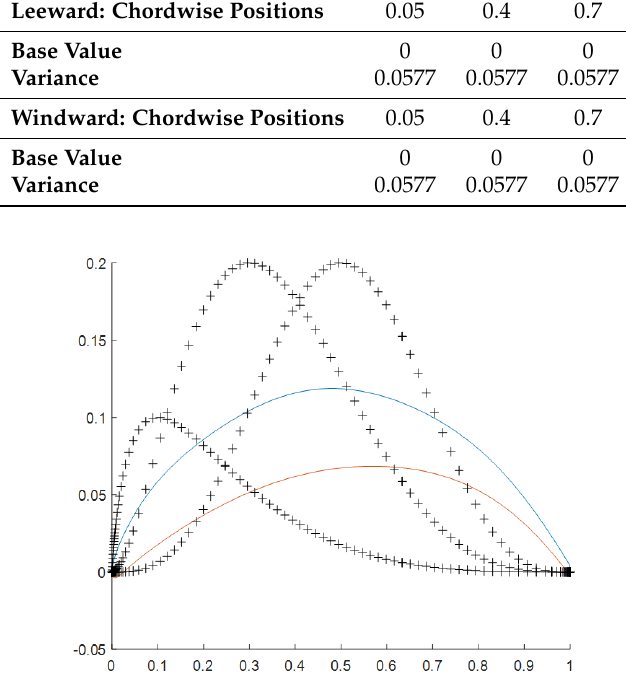
Figure 14. An example of application of bump functions on original